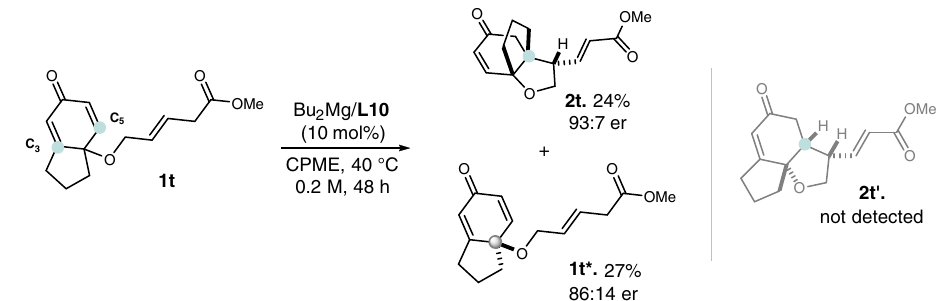
Fig. 5 Site-selective results of the substrate 1t in the KR reaction. Isolated yields are